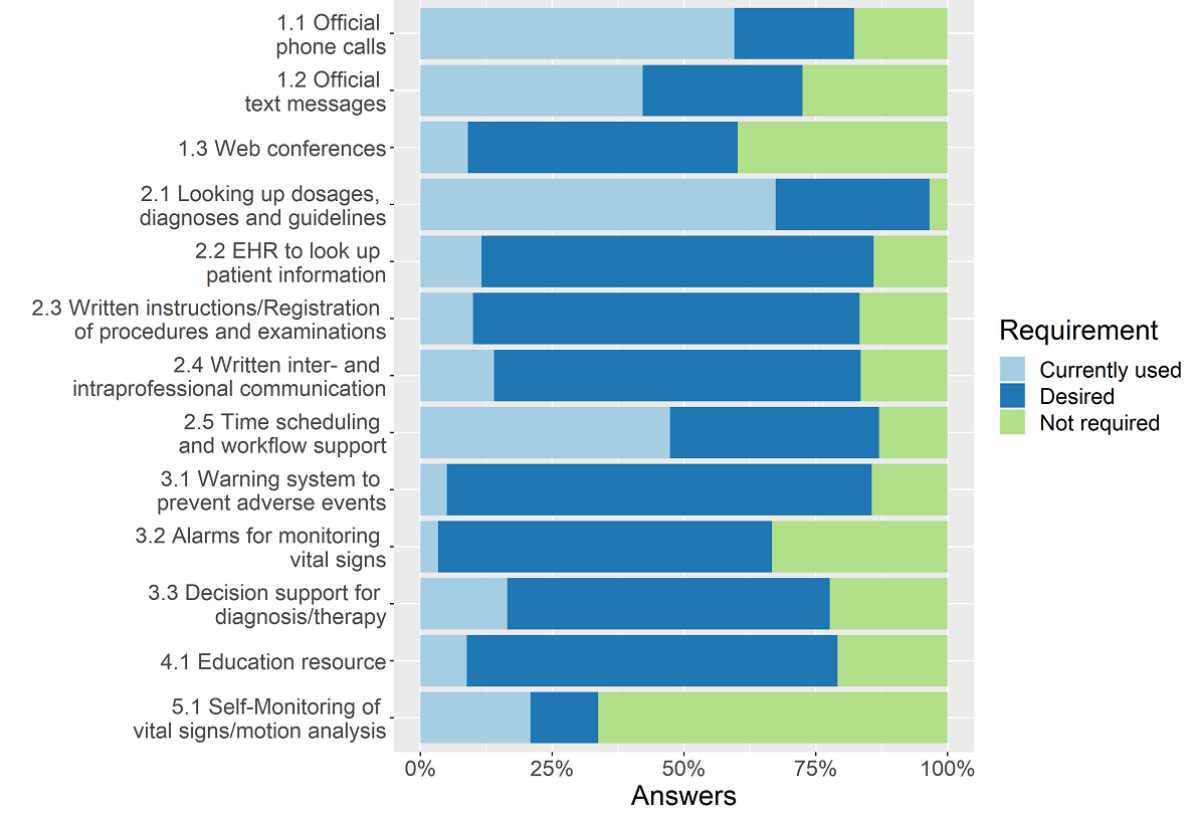
Figure 6. Fields of application and desired functions. EHR: electronic health